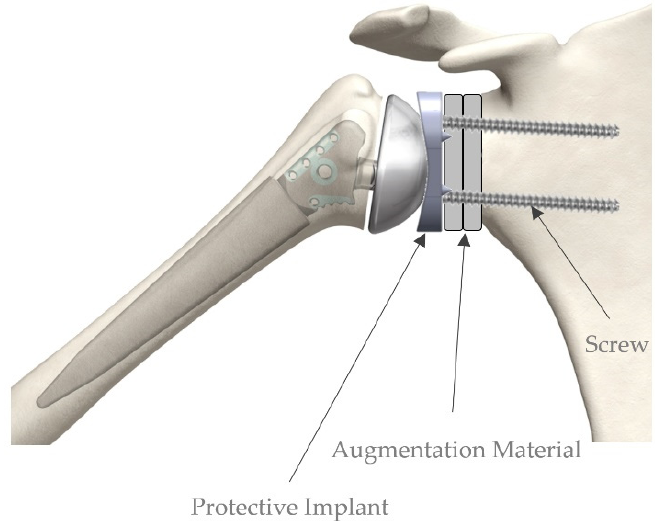
Figure 1. Rigid fixation of the augmentation material.